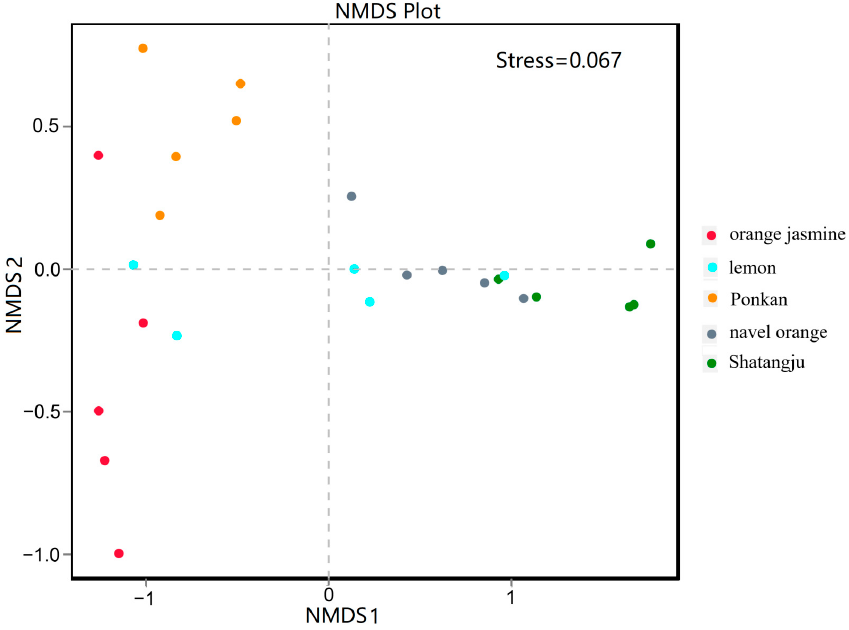
Figure 6. NMDS analysis of the microbial communities based on weighted UniFrac distances. Each signal represents one sample; the distance between samples demonstrates the degree of difference. Stress less than 0.2 indicates the reliability of the NMDS analysis.